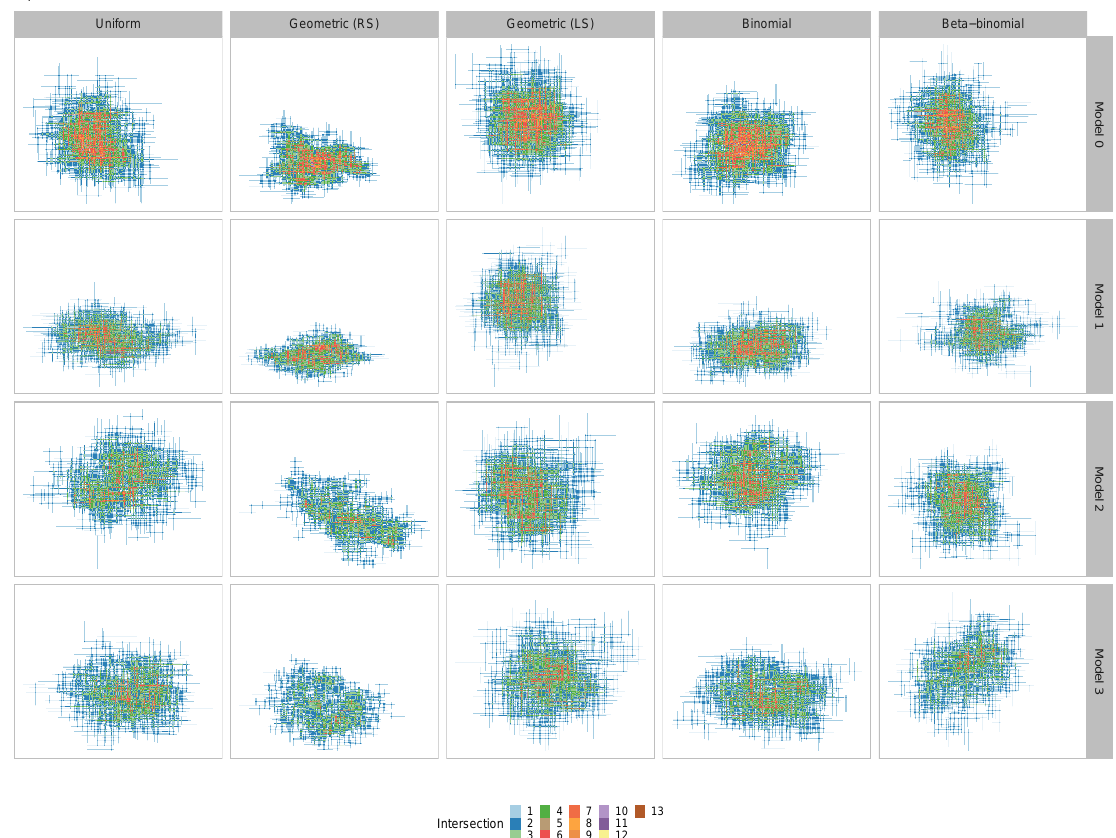
Figure 6. Heat maps of 2D representations of the mesh structure for each model and each initial rod length distribution in the case of O / R = 5 colored with respect to the intersection degree of R